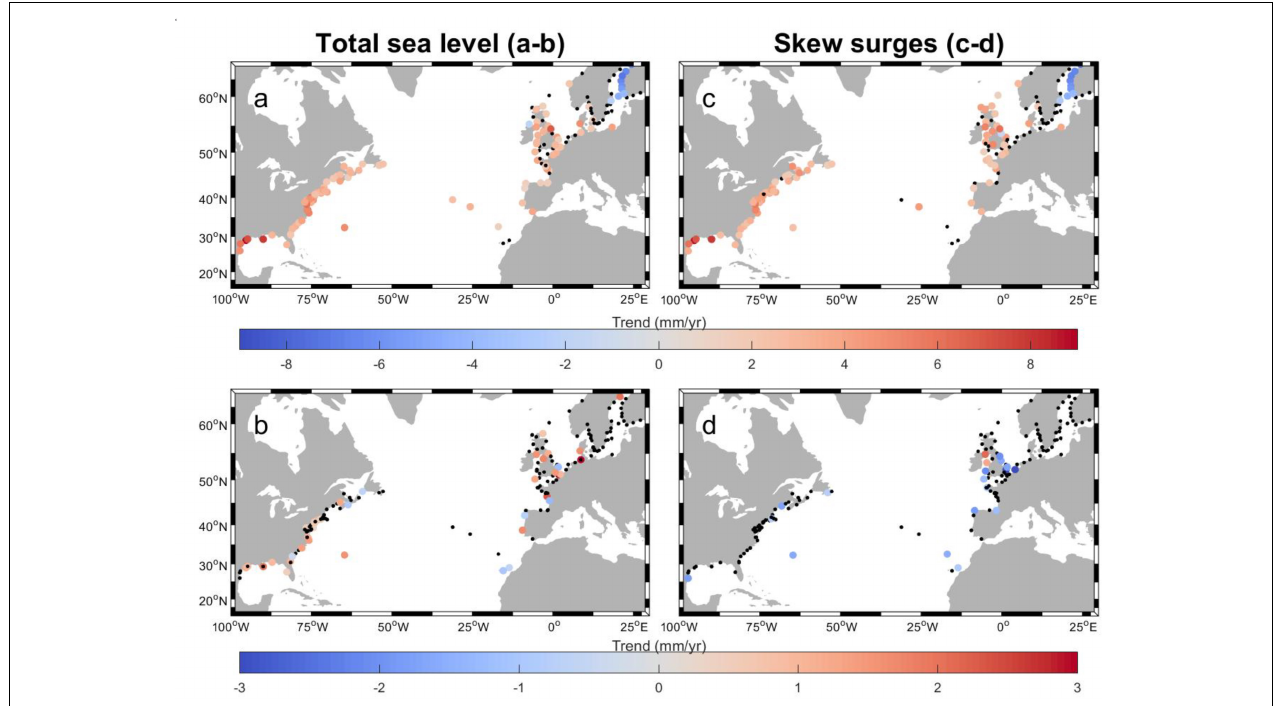
FIGURE 3 | (a) Linear trends of annual 99th percentiles of total sea level and (b) with median removed. (c) Linear trends of annual 99th percentiles of skew surges and (d) with median removed. Tide gauge data from 1960 to present are used. Black dots indicate where the trends are not significant. From Woodworth et al.